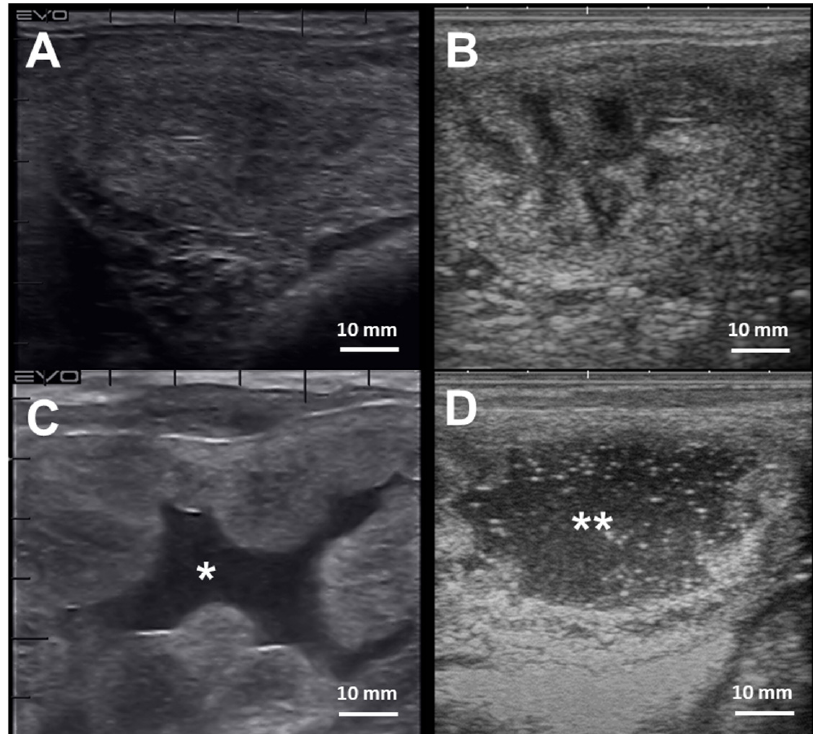
Figure 4. Cross-section ultrasonographic images of the uterine horns in mares: ( A ) An image from the equine uterus with no endometrial edema, or intraluminal fluid accumulation, typically seen in mares during diestrus; ( B ) the uterine horn of a mare in estrus, characterized by the presence of edema in the lymphatic vessels surrounding the endometrium submucosa giving the “orange-slice” aspect, ( C ) Exacerbated endometrium edema with extravasation and intraluminal fluid accumulation (*) in a mare with endometritis, and ( D ) extensive hyperechogenic intraluminal fluid accumulation (**) in a mare with endometritis. Scale bars 10 mm ( A–D )